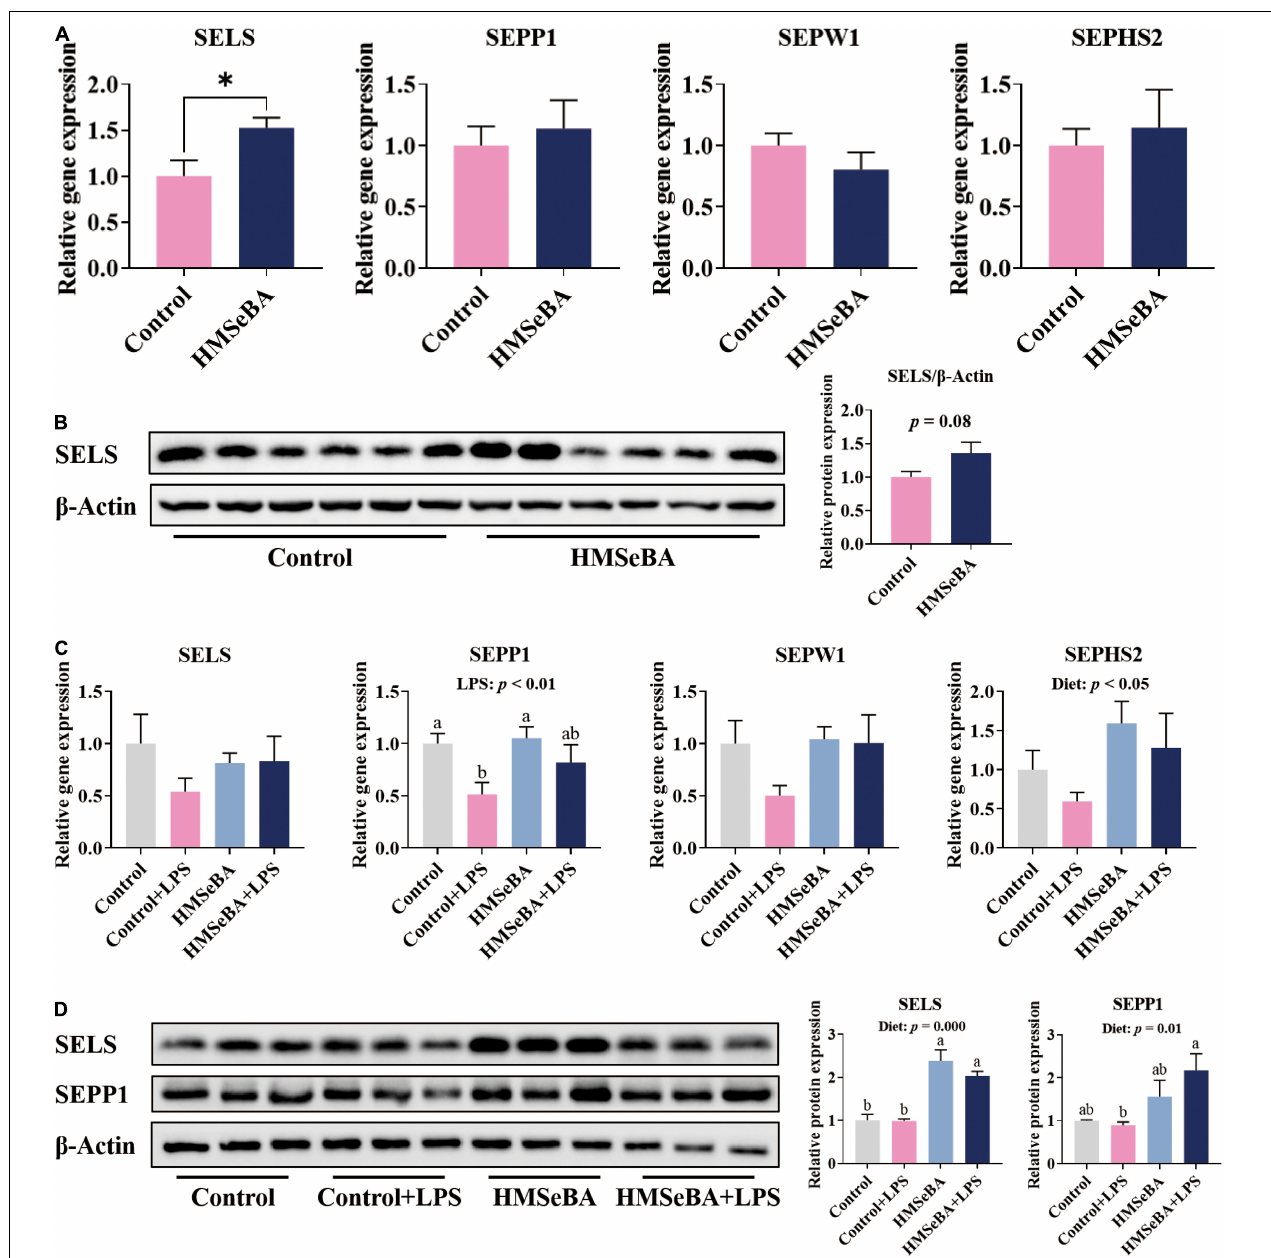
FIGURE 1 | Effect of maternal HMSeBA supplementation during gestation on the expression of selenoprotein in the jejunum of piglets (A) Expression of selenoprotein genes in newborn piglets, n = 10 per group. (B) Relative protein abundance of SELS in newborn piglets, n = 6 per group. (C) Expression of selenoprotein genes in weaned piglets, n = 6 per group. (D) Relative protein abundance of SELS and SEPP1 in weaned piglets, n = 3 per group. Control, basal diet; HMSeBA, basal diet supplemented with HMSeBA, 0.3 mg Se/Kg of HMSeBA. + LPS, piglets challenged with LPS. Data are shown as mean ± SE. ∗ P < 0.05. a, b Columns with different superscript letters mean significant differences ( P <